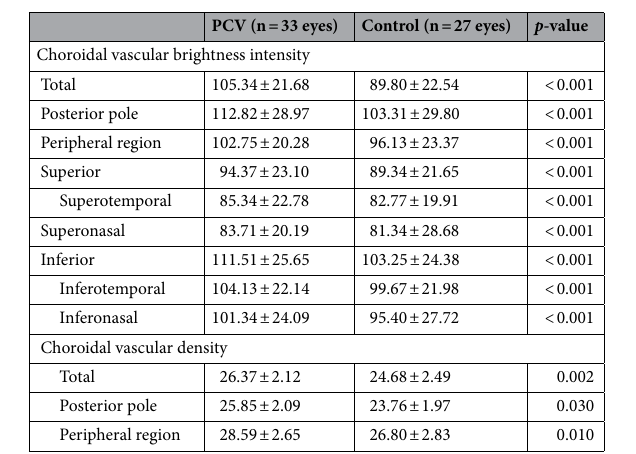
Table 2. Regional distribution of choroidal vascular features in patients with PCV and normal controls. PCV polypoidal choroidal vasculopathy.